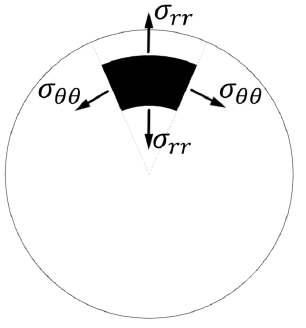
Figure 3: Stress distribution (based on [23])